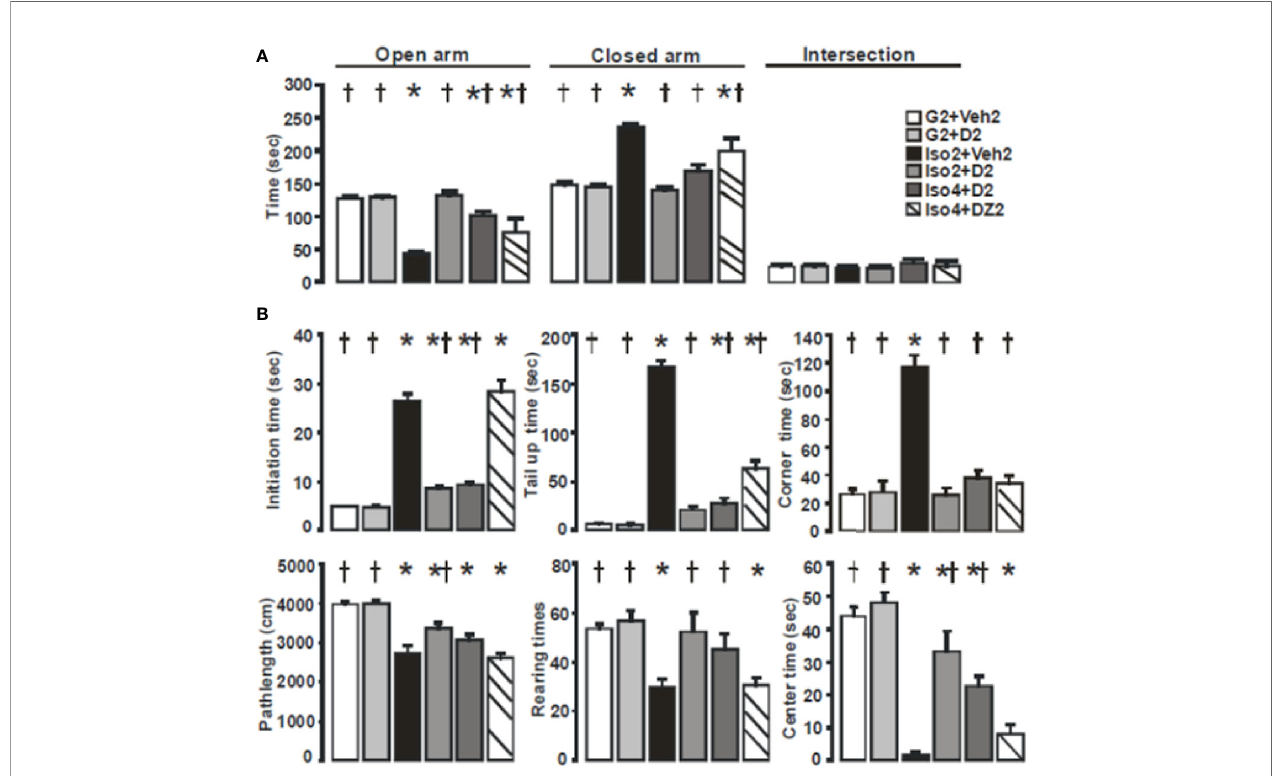
FIGURE 1 | DHM ameliorates social isolation-induced anxiety. (A) Effects of social isolation and treatment with DHM on anxiety-like behavior as measured by the time (s) spent in the open, closed arms, and the area between cross arms (called “ intersection ” ) of the elevated plus maze. one-way ANOVA followed by multiple comparison, Holm-Sidak method. For open arm, F(5, 30) = 26.42, p < 0.001. For close arms; F(5, 30) = 34.81, p < 0.001. For intersection, F(5, 30) = 0.50 p = 0.78. (B) Effects of social isolation and treatment with DHM on locomotor activity, exploratory behavior as measured by initial time (the time duration from when the mouse fi rst placed into the center of the apparatus to start moving), tail up (the time of tail lifting), rearing (total number of times of rearings), path length (total distance of moving), center time (the total time duration the mouse stayed in the center 20 x 20 cm square), and corner (the total duration the mouse stayed in the 4 corner 10x10 cm squares) in the open fi eld assay. One-way ANOVA followed by multiple comparison, Holm-Sidak method. For initial time, F(5, 30) = 108.35, p < 0.001. For tail up, F(5,30) = 184.4, P <0.001. For stay in corners F(5, 30) = 47.1, P < 0.001. For path length, F(5, 30) = 15.9, P < 0.001; For numbers of rearings, F(5, 30) = 7.74, P < 0.001. For stay in the center, P (5, 30) = 34.1, P < 0.001. *, p ≤ 0.05 vs. vehicle group housing control (G2+Veh2). † , p ≤ 0.05 vs. Iso2+Veh2, (n = 6/group).